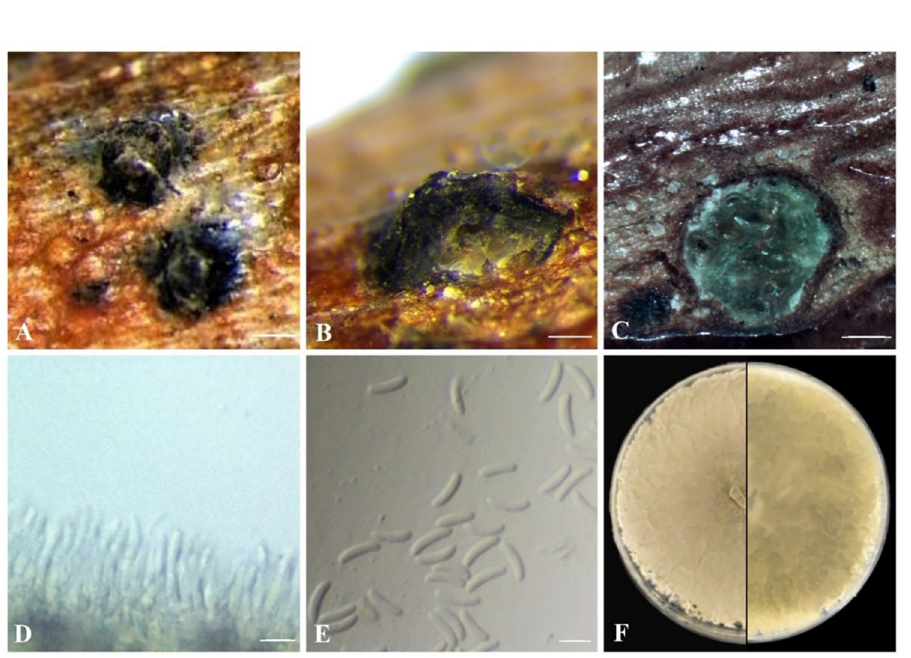
Fig 3. C . paraplurivora on P . persica var. nucipersica (FDS-564). A. Habit of conidiomata on branches. B. Longitudinal section through conidiomata. C. Transverse section of conidiomata. D. Conidiogenous cells. E. Conidia. F. Seven-day-old culture on PDA. Scale bars: A = 200 μ m B-C = 100 μ m, D-E = 5 μ m.